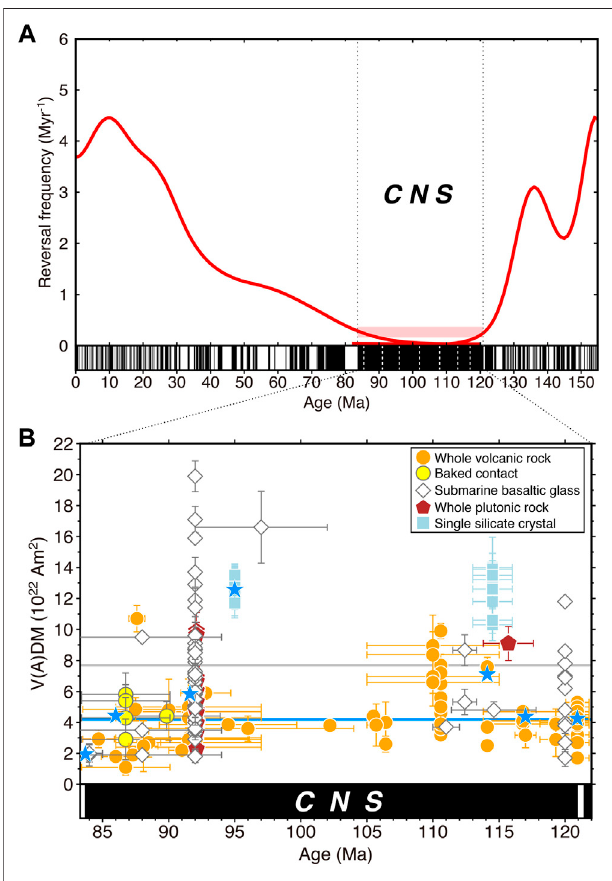
FIGURE 1 | (A) Geomagnetic polarity time scale for 0 – 154.9 Ma based on Ogg (2020) and geomagnetic reversal frequency curve calculated using fi xedkerneldensityestimation(Constable,2000).Possibleshortgeomagnetic reversal events during the CNS are shown as dashed white lines based onthesummaryofZhangetal.(2021).Notethatthedurationoftheeventsare not re fl ected in this fi gure. Constable (2000) calculated the reversal frequency from Harland et al. (1990) and Cande and Kent (1995). Pink zone expresses a range of the geomagnetic reversal frequency during the CNS (Chron C34n) calculated from short geomagnetic reversal events during the Superchron suggested by Zhang et al. (2021). Dotted gray lines express a time interval of the CNS. The CNS, Cretaceous Normal Superchron. (B) Virtual (axial) dipole momentsduring the CNS (Cottrell and Tarduno, 2000; Pickand Tauxe, 1993; Juarez et al., 1998; Thomas et al., 2000; Riisager et al., 2001; Tarduno et al., 2001;TanakaandKono,2002;Tardunoetal.,2002;Zhuetal.,2002;Riisager et al., 2003; Tauxe and Staudigel, 2004; Zhu et al., 2004a; Zhu et al., 2004b; Zhao et al., 2004; Shi et al., 2005; Tauxe, 2006; Granot et al., 2007; Shcherbakova et al., 2007; Shcherbakova et al., 2008; Zhu et al., 2008; Shcherbakova et al., 2009; Tsunakawa et al., 2009; Qin et al., 2011; Shcherbakova et al., 2011; Shcherbakova et al., 2012; Di Chiara et al., 2021). Thelong-termmedianvalueandthemediansof5Myrbinsforthelast200Myr by Tauxe et al. (2013) and Tauxe and Yamazaki (2015) are displayed by the solid blue line and the blue stars, respectively. The present fi eld intensity is indicated by the solid gray line.